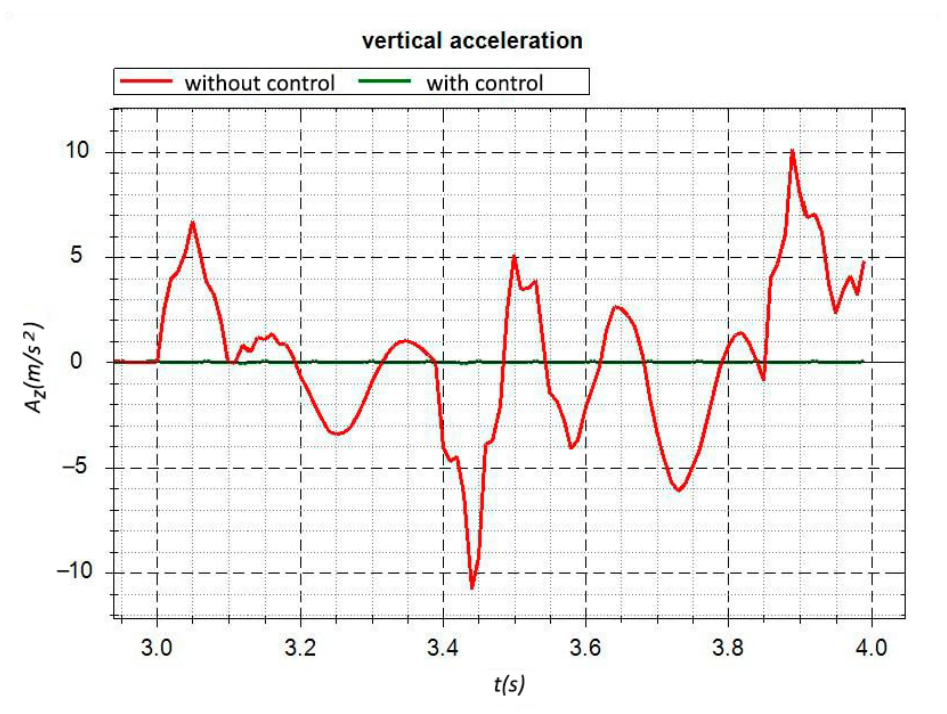
Figure 6. Vertical acceleration in the car’s front